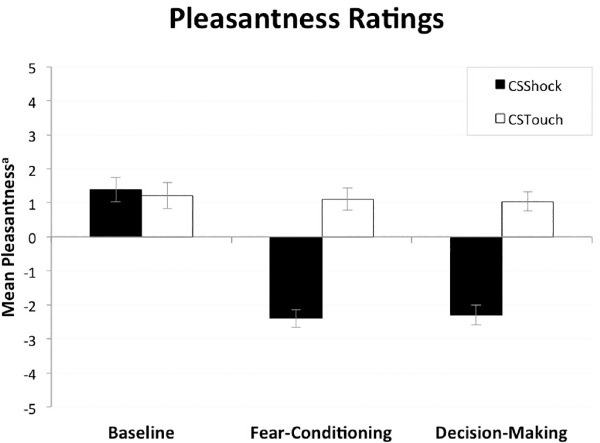
Fig 2. Mean pleasantness ratings for the fear-conditioned (CS Shock ) and neutral (CS Touch ) stimulus as a function of experimental phase (i.e., baseline, after fear conditioning, and after the decision-making task). Error bars depict standard error of the mean. a 5 = very pleasant ; -5 = very unpleasant .